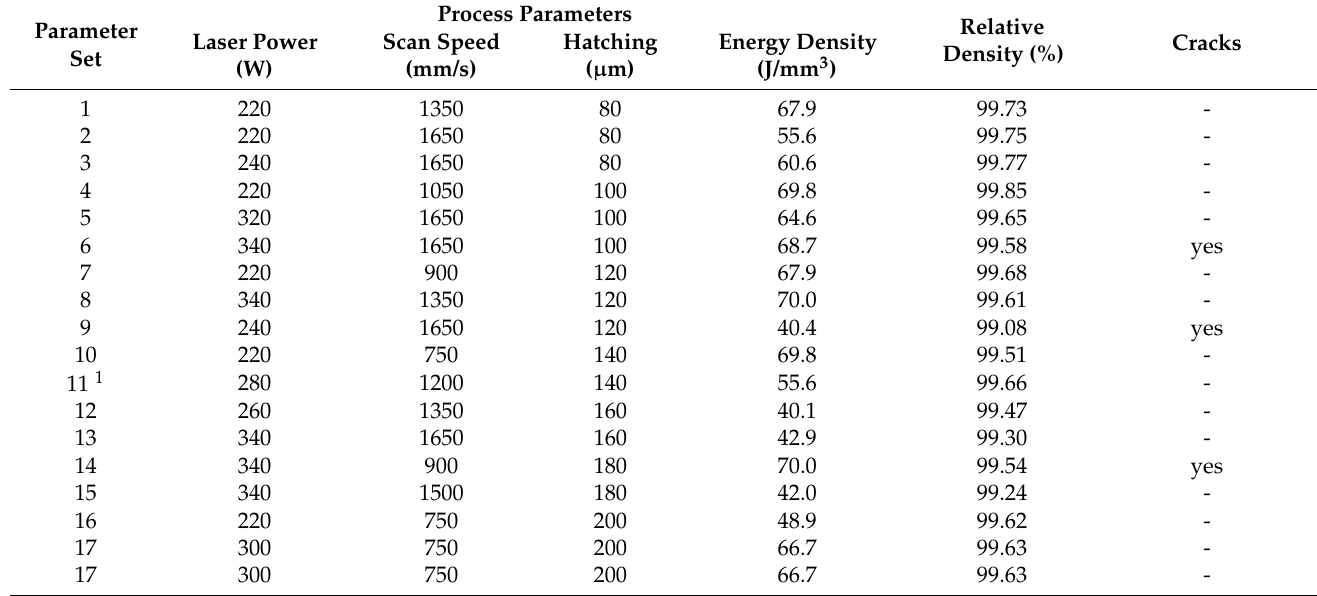
Table 4. The DoE parameter sets used and their achieved densities and visible crack